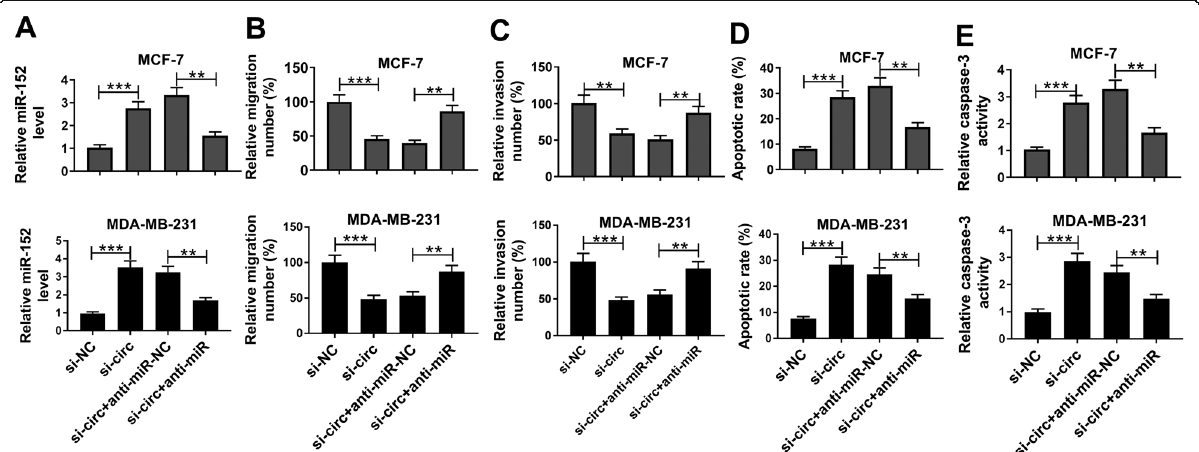
Fig. 5 Depletion of miR-152 weakened the impacts of circKIF4A knockdown on migration, invasion and apoptosis of BC cells. MCF-7 and MDA- MB-231 cells were assigned to si-circKIF4A, si-NC, si-circKIF4A + anti-miR-152 and si-circKIF4A + anti-miR-NC groups. ( a ) The expression of miR-152 was detected by qRT-PCR. ( b and c ) Cell migration and invasion were evaluated by transwell assay. ( d ) Cell apoptosis ability was evaluated using flow cytometry assay. ( e ) Caspase-3 level was examined by qRT-PCR. **P < 0.01, ***P <